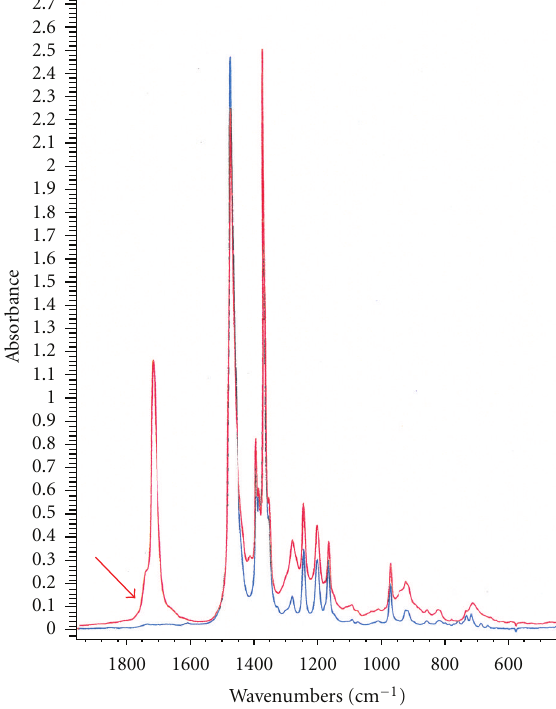
Figure 2: IR spectrum of 20% solution of CTO before (red line) and after reaction (blue